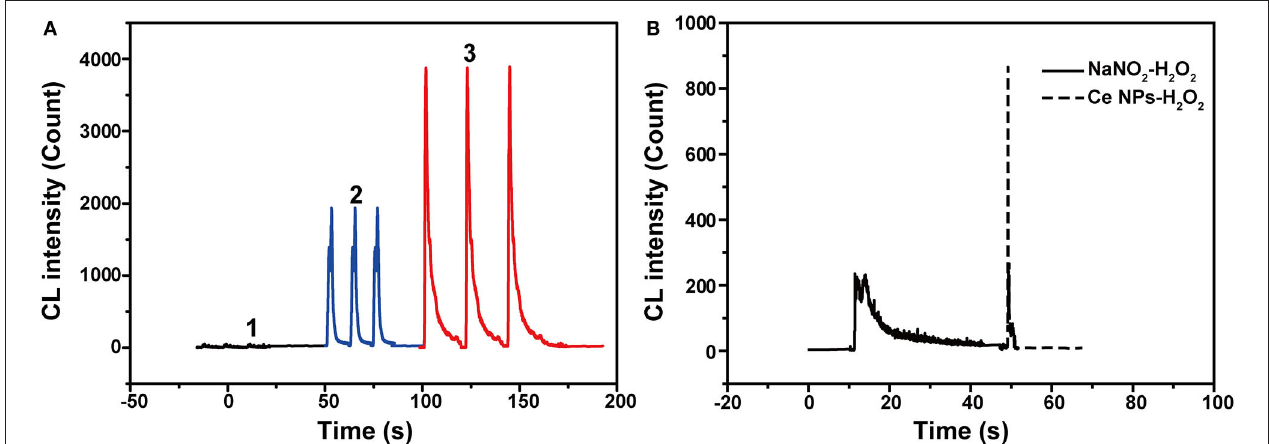
FIGURE 3 | CL kinetic study of the LaF 3 :Ce NPs-NaNO 2 -H 2 O 2 system. (A) CL kinetic curves of the LaF 3 :Ce NPs-NaNO 2 -H 2 O 2 system with different reagent mixing orders: 1 . injecting LaF 3 :Ce NPs into the mixture of NaNO 2 and acidified H 2 O 2 ; 2 . injecting NaNO 2 into the mixture of LaF 3 :Ce NPs and acidified H 2 O 2 ; 3 . injecting acidified H 2 O 2 into the mixture of LaF 3 :Ce NPs and NaNO 2 . CL signals of three repeated experiments were given. (B) CL kinetic curves of the NaNO 2 -H 2 O 2 system and the LaF